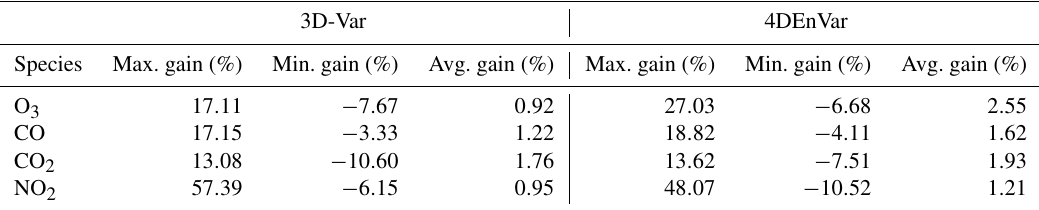
Table 6. Summary statistics of RMSE gain for perfect model DA experiments in Fig. 4. Signs have been inverted compared to figures to show positive values when DA reduces the RMSE. 3D-Var